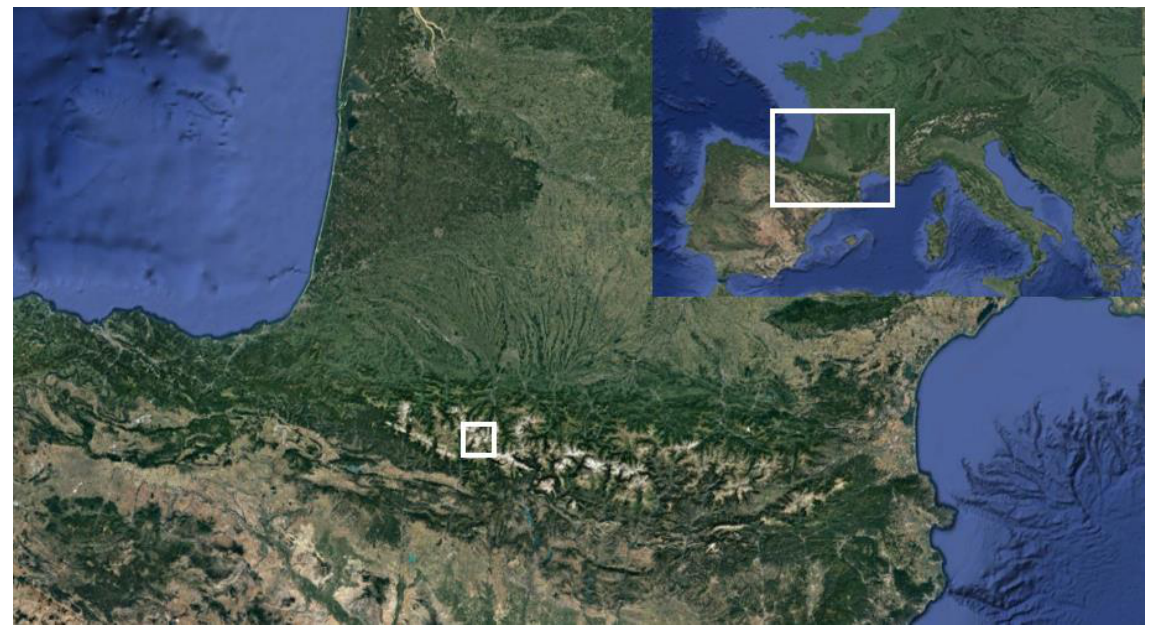
Figure 1. Location of the Infierno Glacier. Pyrenees Mountain range, northern part of the Huesca province (Aragon, Spain). The small box marks the situation of the Upper Gállego River basin. Source: Google Earth [32].